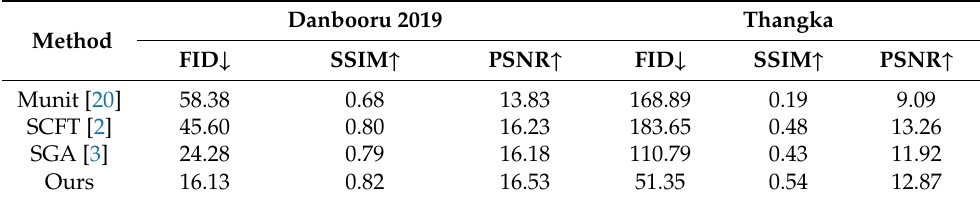
Table 1. Quantitative comparisons show that our model trained for Thangka colorization outperforms the models trained by SCFT [2], SGA [3] and Munit [20] (tests are conducted on both the Danbooru 2019 dataset of 2000 images and the Thangka dataset of 581 images). FID [34] score: a lower score is better. PSNR and SSIM score: a higher score is